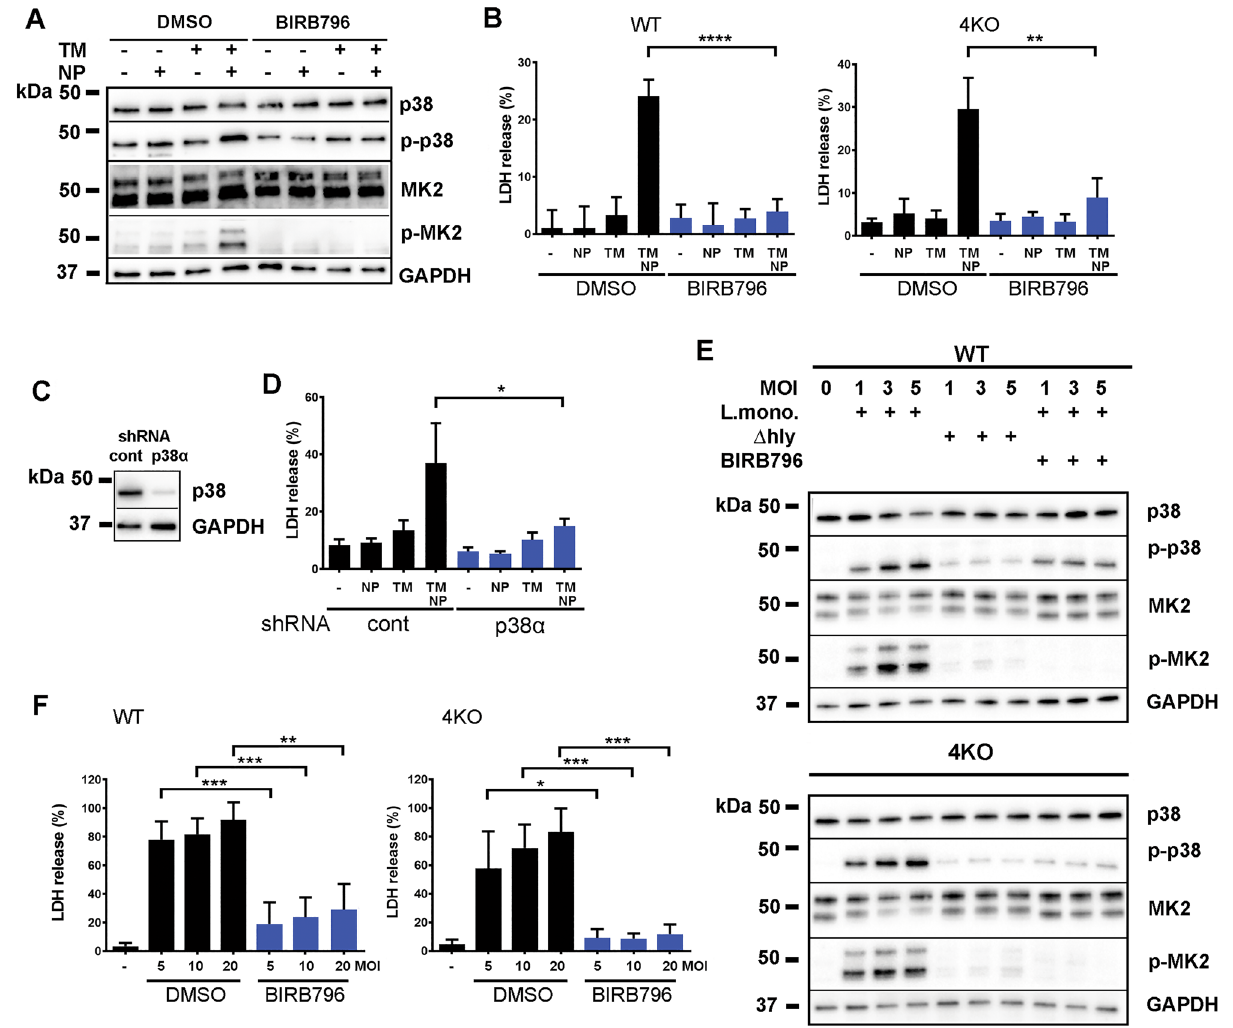
Figure 5. p38MAPK mediates necrotic death of BMDM after their exposure to L.monocytogenes or synthetic nanoparticles. (A) Western blotting analysis of BIRB796-mediated inhibition of p38 and MK2 activation in 4KO BMDMs after their treatment with DMSO (-), TM, NP, or TM and NP combination. N = 2. (B) LDH release from WT and 4KO BMDMs in the presence or absence of BIRB796, after cell treatment with